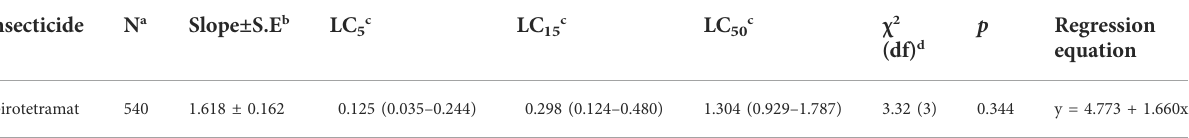
TABLE 1 Bioassay of Spirotetramat on apterous adults of Brevicoryne brassicae . Insecticide N a Slope±S.E